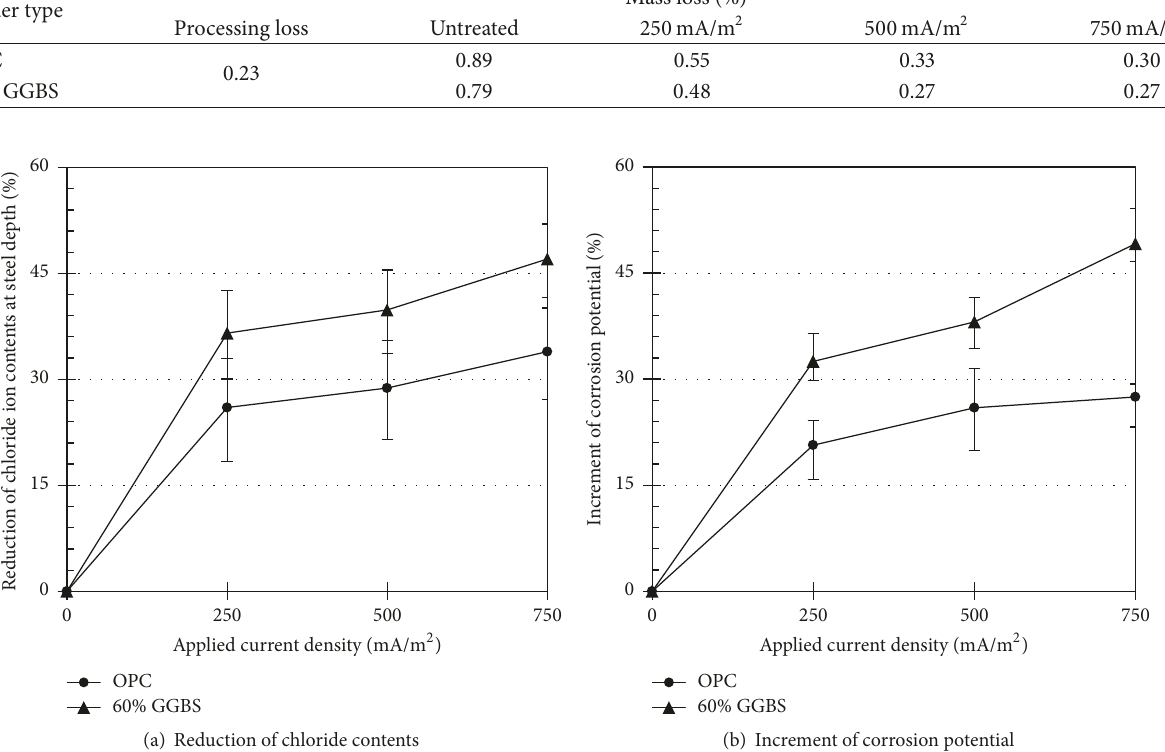
versus SCE, increased to − 520, − 485, and − 475 at